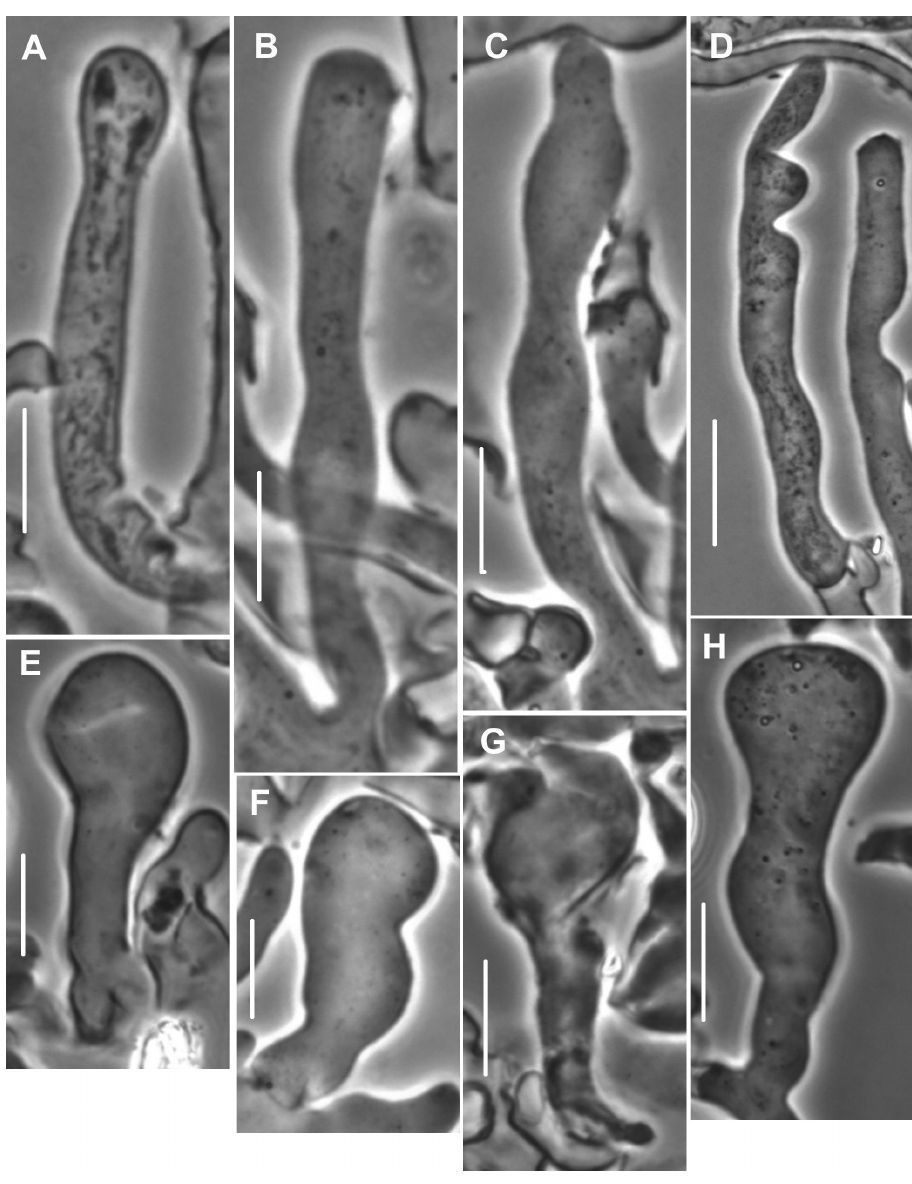
Figure 12. Mycetinis applanatipes . Pileipellis structures. A–D Pileal hairs E–H Inflated hyphal termini. Standard bars = 10 µm. DED 6628 (SFSU-F- 024637). (wall -0.6 µm thick, hyaline; 3) similar scattered elements with dense contents, usually branched or lobate; and 4) scattered thick-walled lobate elements (Fig. 14C, D) with densely, strongly pigmented contents. Pileus trama loosely interwoven, composed of hyphae of three types: 1) filamentous, 3–8(-15) µm diam, firm-walled,